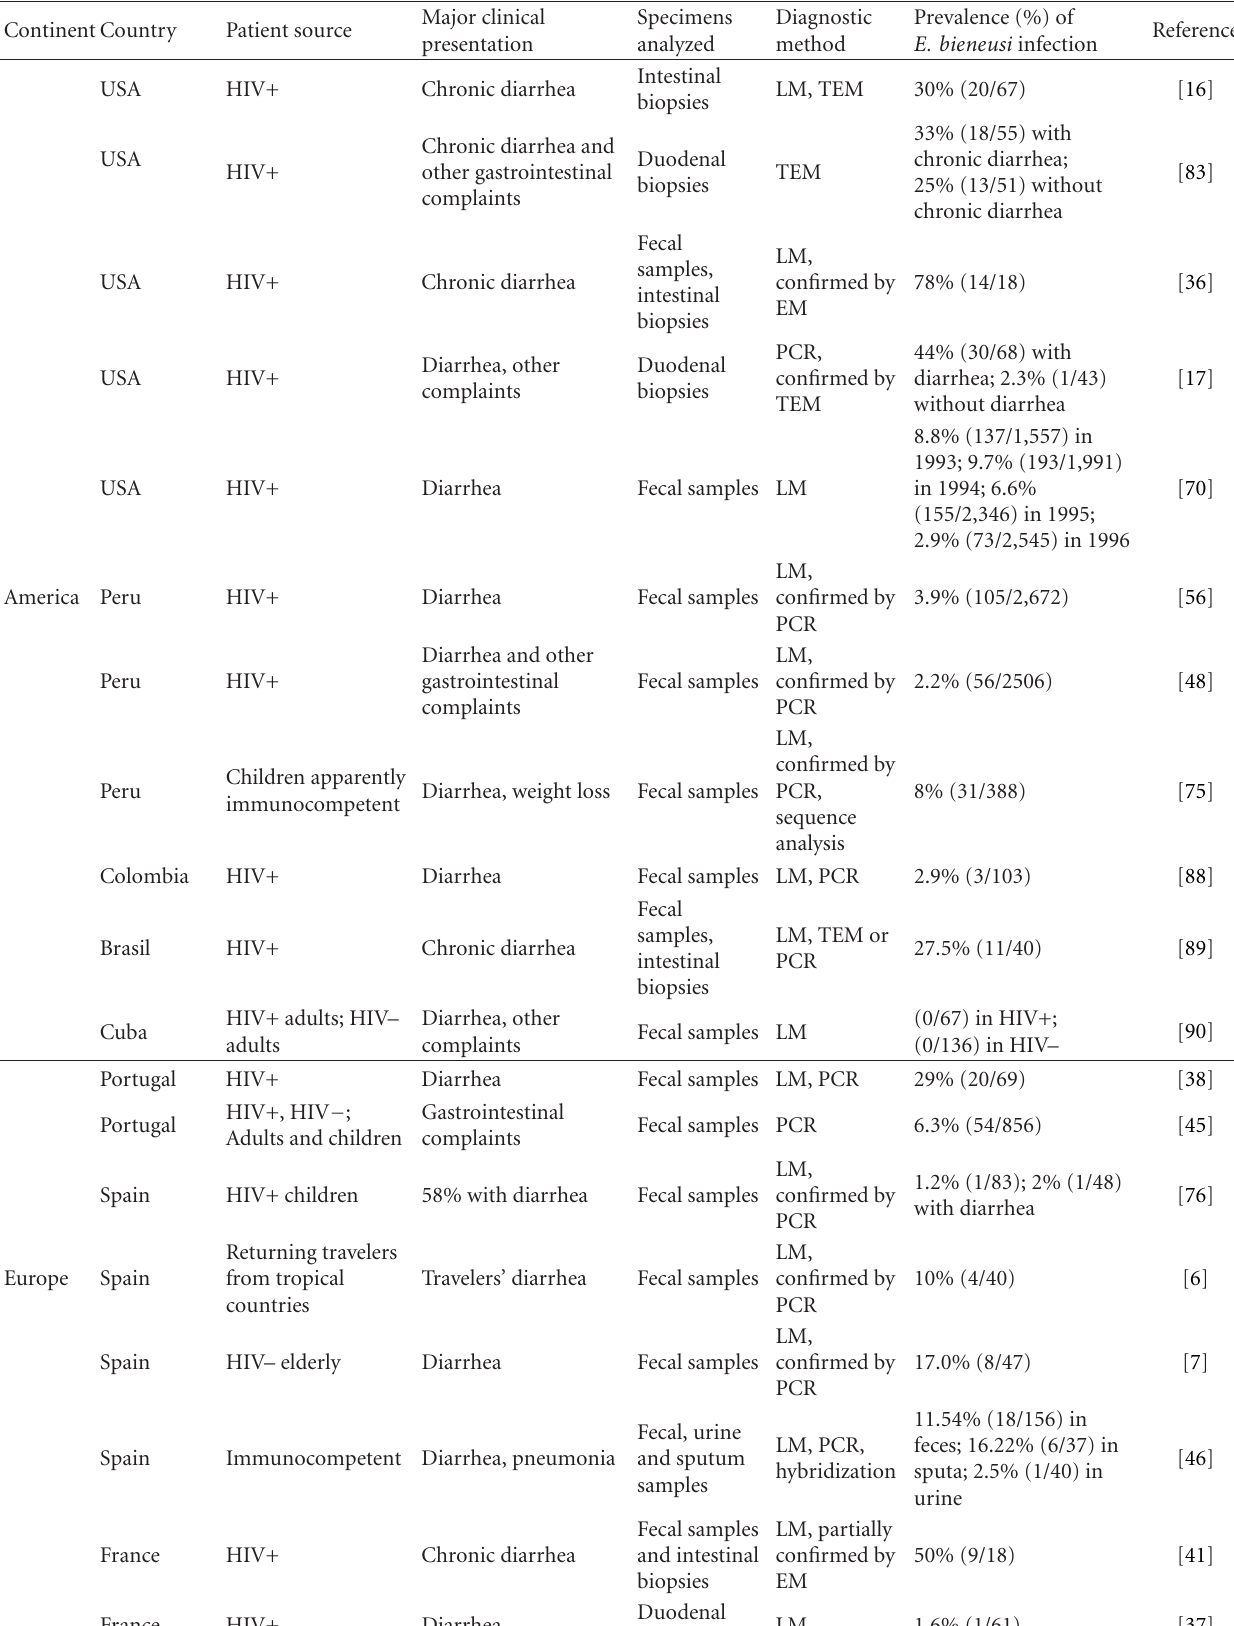
Table 1: Studies on prevalence of Enterocytozoon bieneusi infection in